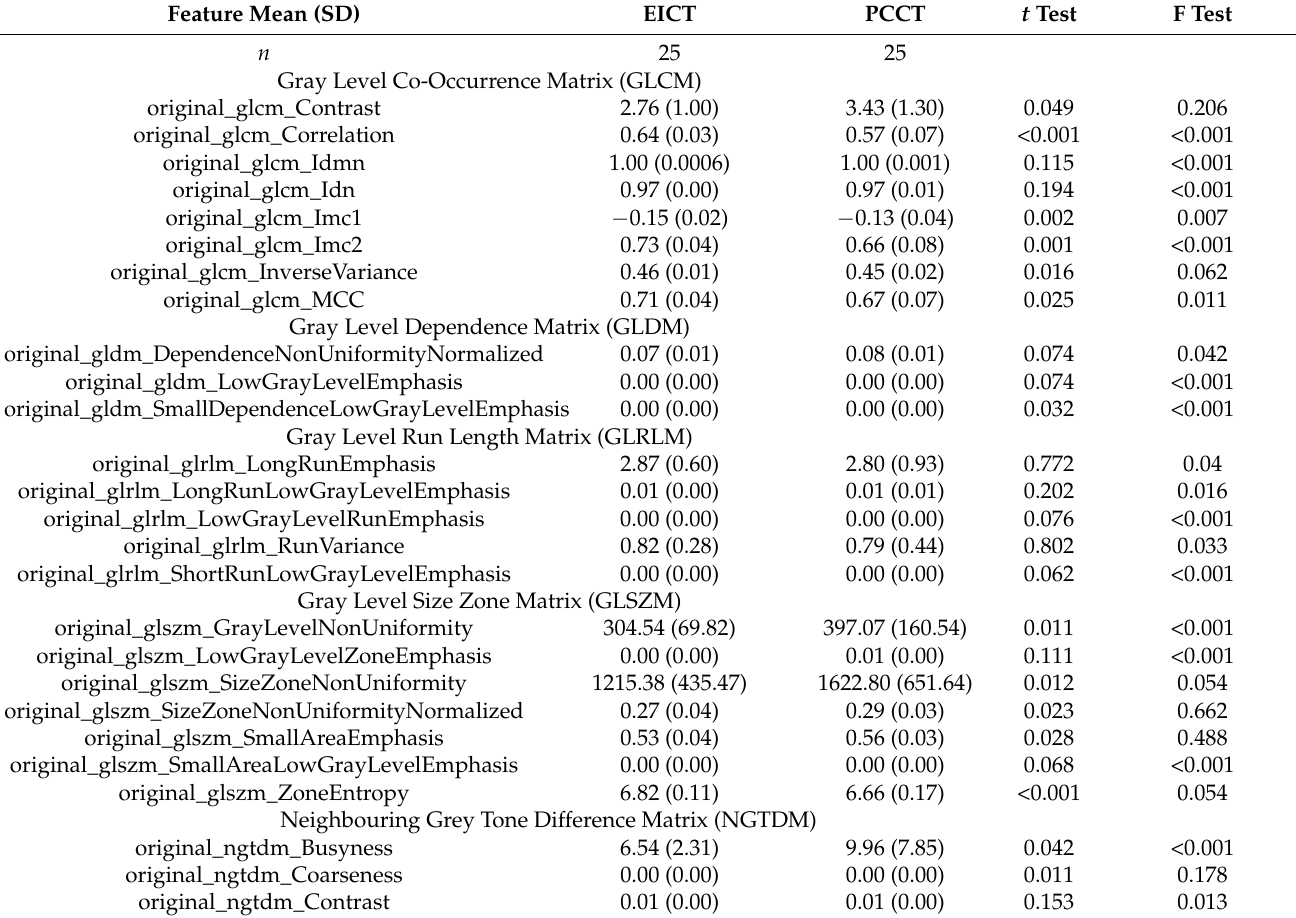
Table 3. Higher order radiomics features, with significant differences in mean and/or